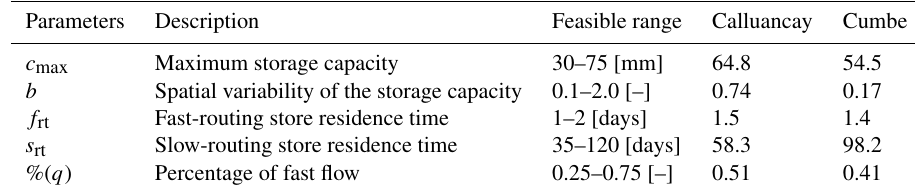
Table 2. The calibrated parameters of the PDM